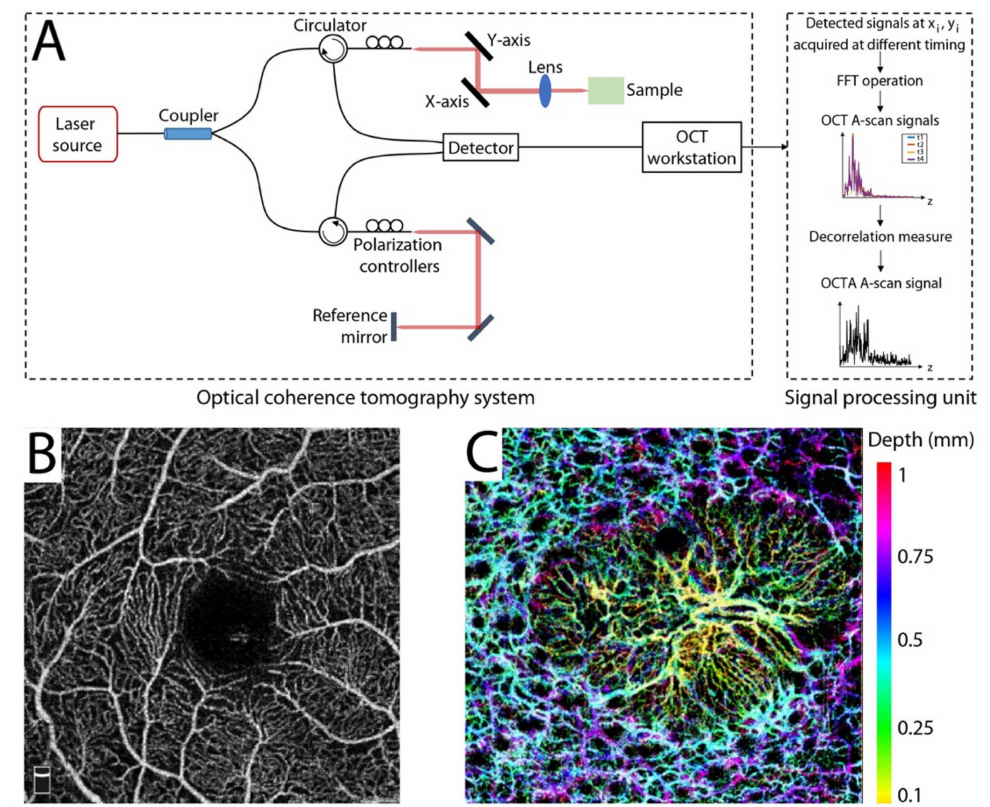
Figure 2. ( A ) Simple block diagram of an OCT system and the signal processing unit to obtain OCTA A-scan signals. ( B ) Example of en face ophthalmology OCTA image. Image available in the ROSE dataset [13]. ( C ) Example of dermatology OCTA volume, color coded by